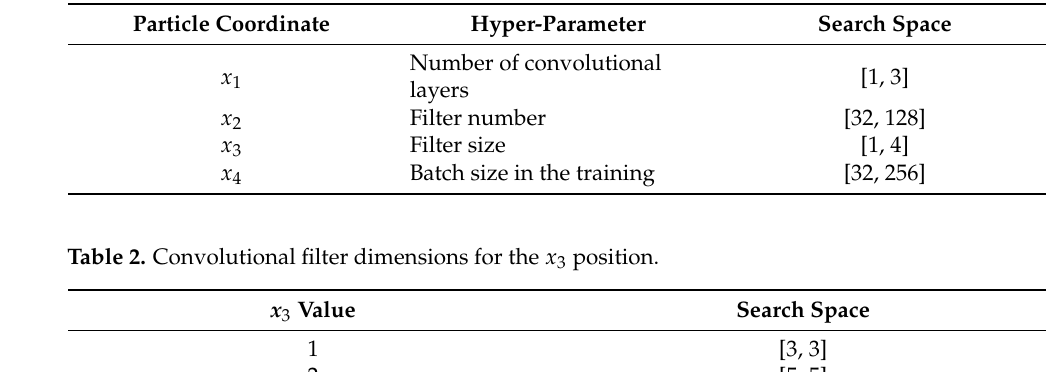
Figure 8. Structure of the particle used in the PSO-CNN-I approach. Table 1. Search spaces used to define the particle in the PSO-CNN-I approach.